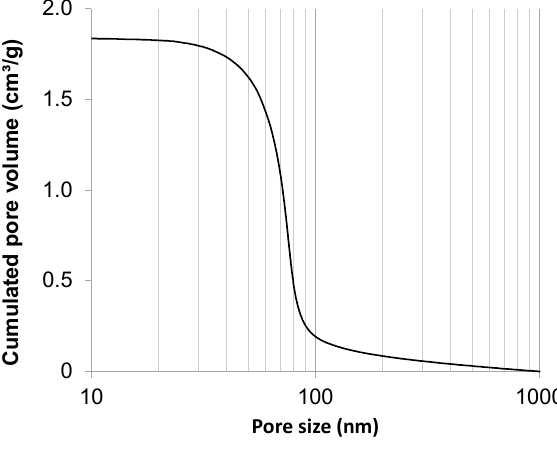
Figure 1. Cumulative pore volume vs. pore size of the carbon xerogel support (micropores excluded) calculated from Hg porosimetry